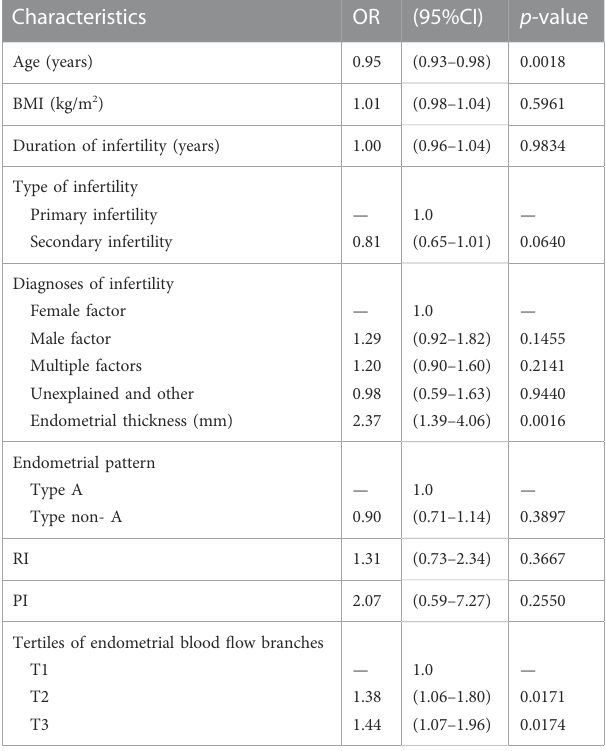
TABLE 2 Factors correlated to pregnancy outcomes by a univariate analysis. Characteristics